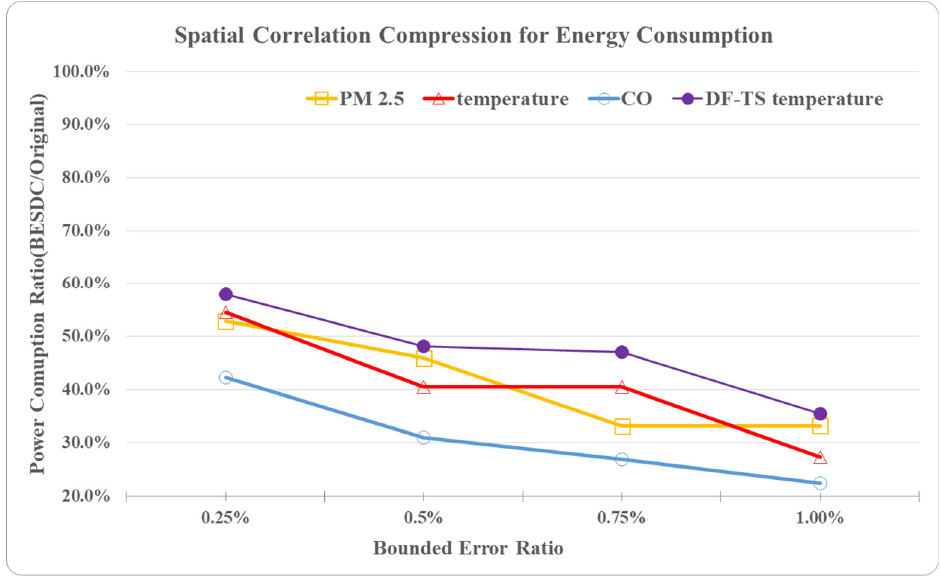
Figure 9. Energy consumption ratio in SN with neighboring EDs by spatial correlation compression.